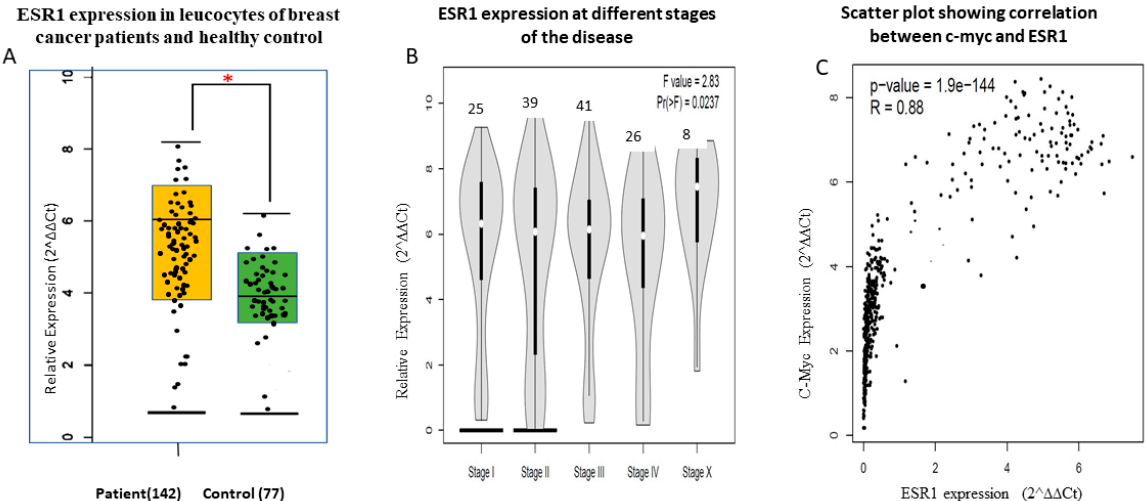
Figure 6. ( A – C ) ESR1 in leucocytes of breast cancer patients (142) and 77 healthy control and normalized it with housekeeping gene by Livak 2 ∆∆ Ct method. ( A ) The mean RE (2 ∆∆ Ct ) in patient is higher than in control group. Welch’s t -test showed the significance of results at ( p -value < 0.00623) for 142 patients and 77 control samples. ( B ) analysis of variance (anova) F value (2.8) with significance of Pr(>F) = 0.0237, ( C ) c-myc and ESR1 showed strong spearman correlation coefficient R = 0.88. Asterisks represent significance at 0.05 level.